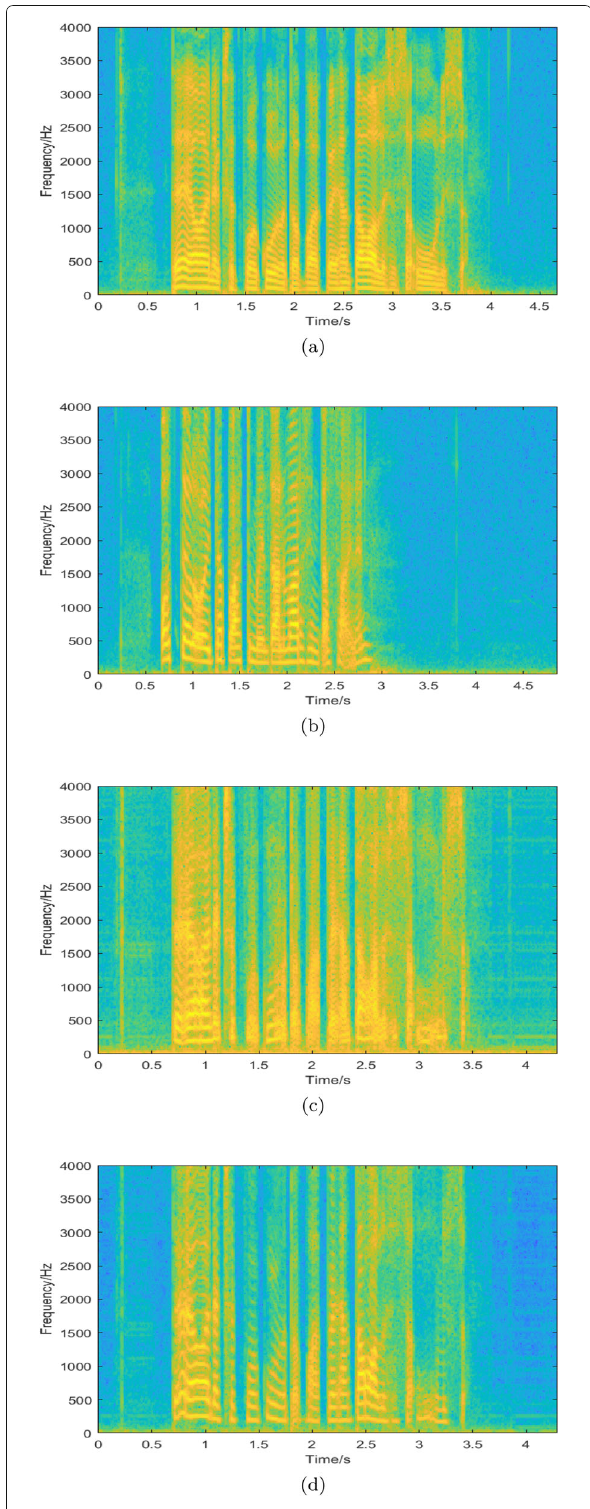
Fig. 7 Comparison among source, target, and the converted spectrograms in cross-lingual scenario(VCC2VCC). a Source speech. b Target speech. c The converted speech of AGAIN-VC. d The converted speech of U 2